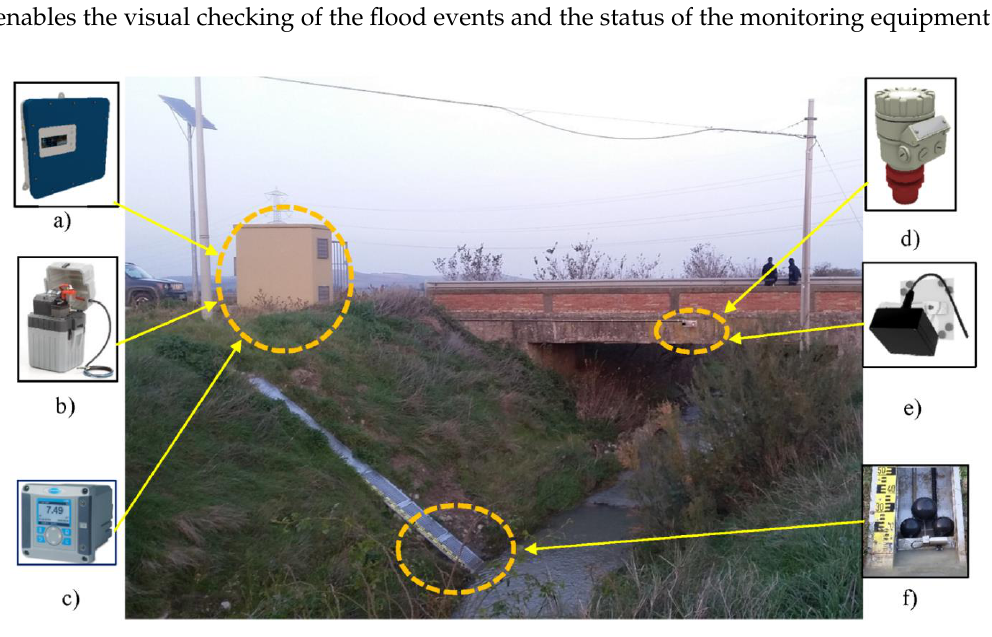
Figure 3. Monitoring station equipment: ( a ) modular transmitter; ( b ) automatic sampler; ( c ) turbidity probe controller; ( d ) ultrasonic level sensor; ( e ) optical velocity sensor; ( f ) turbidity probe, floating system and flow level gauge.